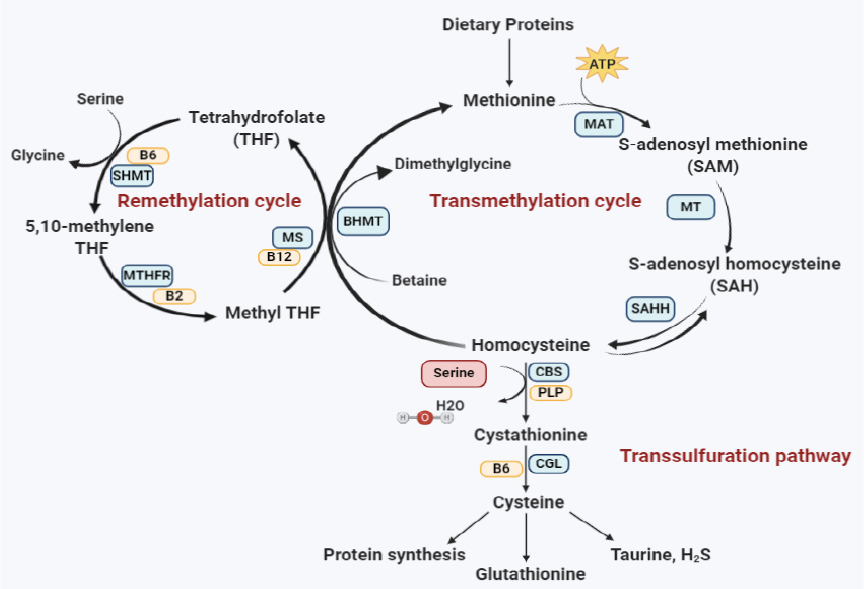
Figure 1. Homocysteine metabolism pathway. Methionine adenosyltransferase (MAT); methyltransferase (MT); S-adenosylhomocysteinase hydrolase (SAHH); betaine-homocysteine methyltransferase (BHMT); pyridoxal-phosphate (PLP); cystathionine gamma-lyase (CGL); methionine synthase (MS); serine-hydroxymethyltransferase (SHMT); methyl-tetrahydrofolate-reductase (MTHFR), hydrogen sulfide (H 2 S).